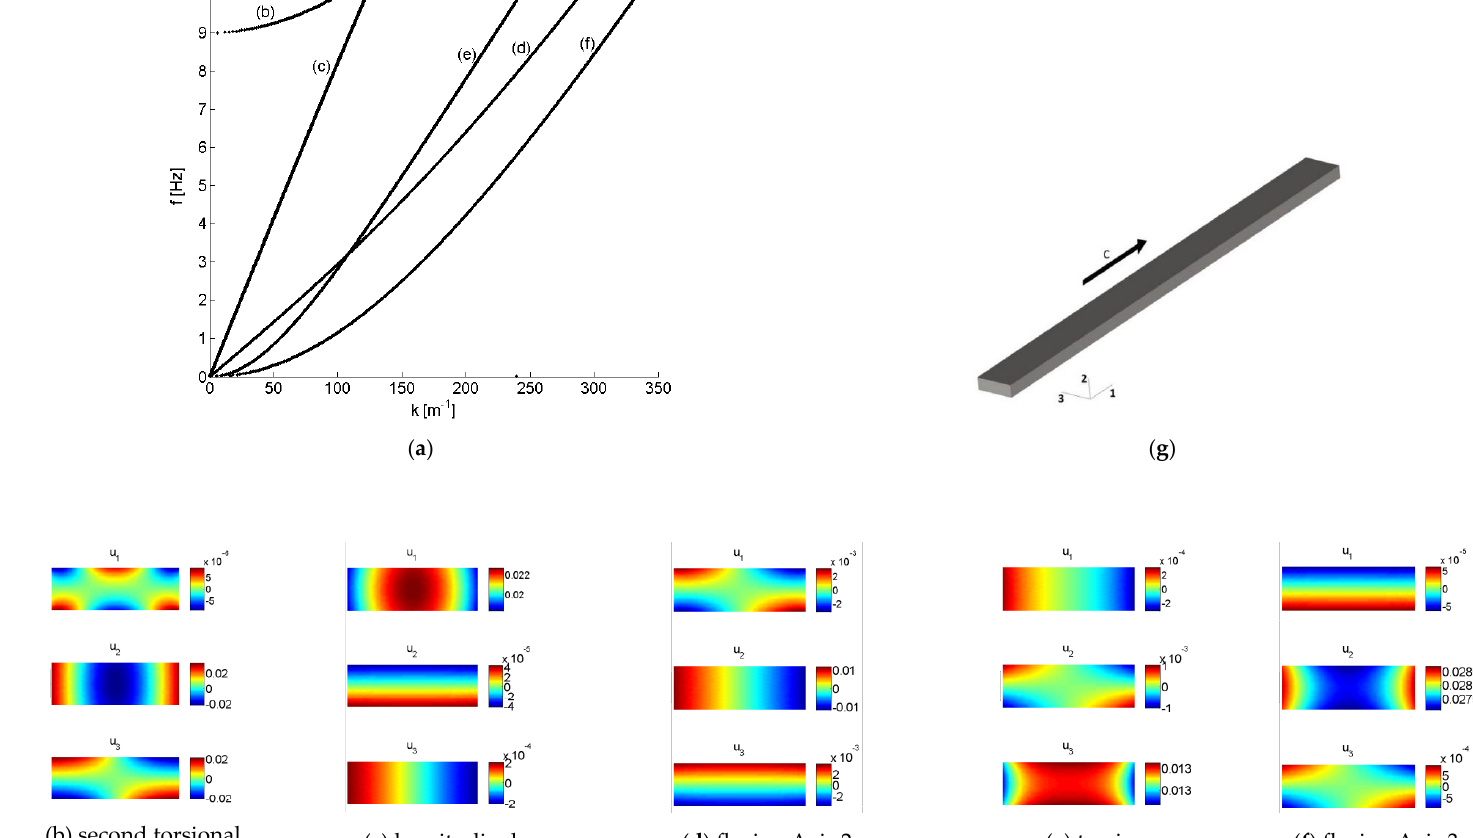
Figure 5. ( a ) Dispersion curves computed using the Pedroi et al. method presented in [28]. Displacement field of ( b ) second torsional, ( c ) longitudinal, ( d ) torsional, ( e ) flexural (around Axis (2)), ( f ) flexural wave mode (around Axis (3)). ( g ) The waveguide scheme with the reference axes indicated. Notice that in this graph the wave number is defined as k = 2 π / λ [m − 1